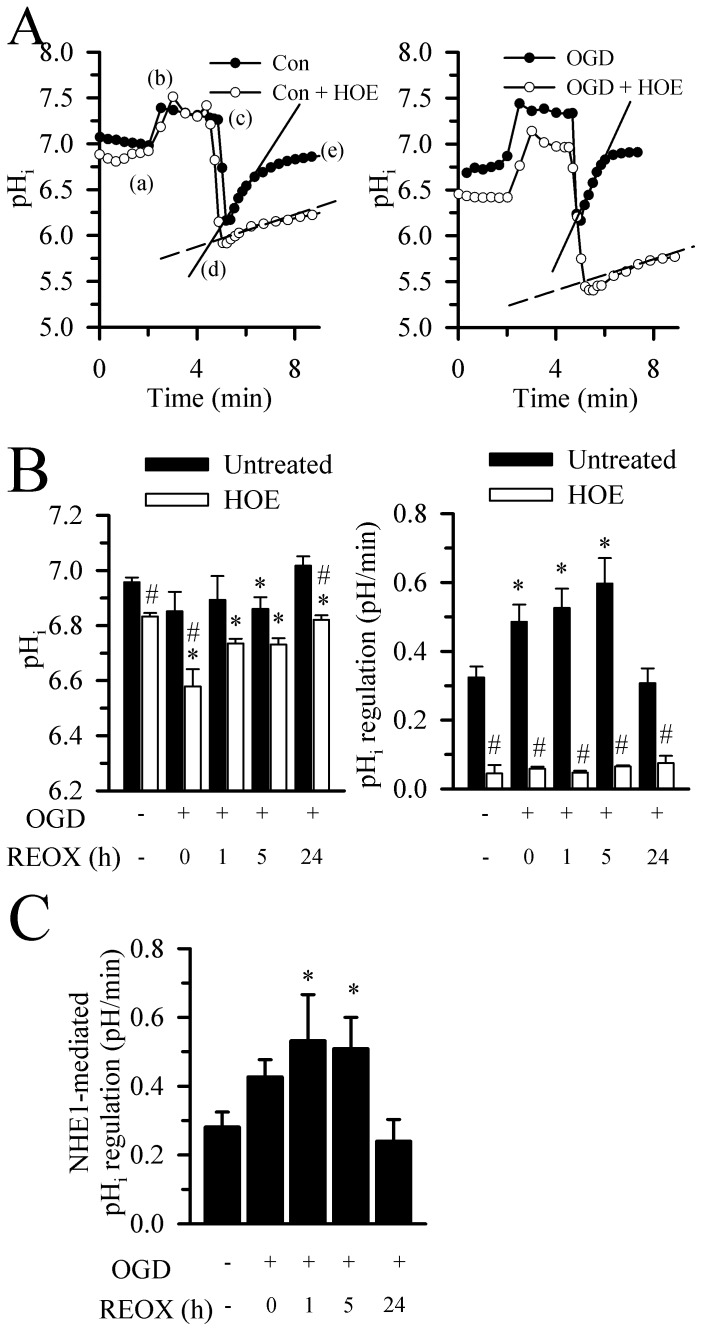
Increased NHE1 activity in hippocampal astrocytes following OGD/REOX.
A. pHi changes were determined by BCECF-AM dye in astrocytes subjected to NH4
+/NH3 prepulse-mediated acid-loading. Either normoxic astrocytes (left panel) or astrocytes at 2 h OGD (right panel) were exposed to 30 mM NH4Cl3 (a–c), then returned to standard HCO3
–free HEPES-MEM solution (c–e). After an initial acidification, pHi recovery followed (d–e). The pH recovery rates were determined at ∼ 6.5 to normalize for the allosteric regulation of H+ on NHE1 activity. A slope of the pH i changes following the prepulse was calculated as pHi recovery rate (solid or dashed line). For HOE 642 treatment, the drug was present throughout the experiment. B. pHi (left panel) and pHi recovery rates (right panel) were summarized under normoxic control, 2 h OGD, or 1, 5, or 24 h REOX conditions. C. Summary data of NHE1-mediated recovery rates under normoxic and OGD/REOX conditions. The values of ∼20 cells from each coverslip/culture were averaged. The n values were the number of cultures under each condition and indicated as normoxia (9), normoxia+HOE 642 (6), 0 REOX (5), 0 REOX+HOE 642 (4), 1 h REOX (3), 1 h REOX+HOE 642 (4), 5 h REOX (5), 5 h REOX+HOE 642 (4), 24 h REOX (4) and 24 h REOX+HOE 642 (3). Data are expressed as mean ± SEM. *p<0.05 vs. corresponding untreated. # p<0.05 vs. corresponding untreated.